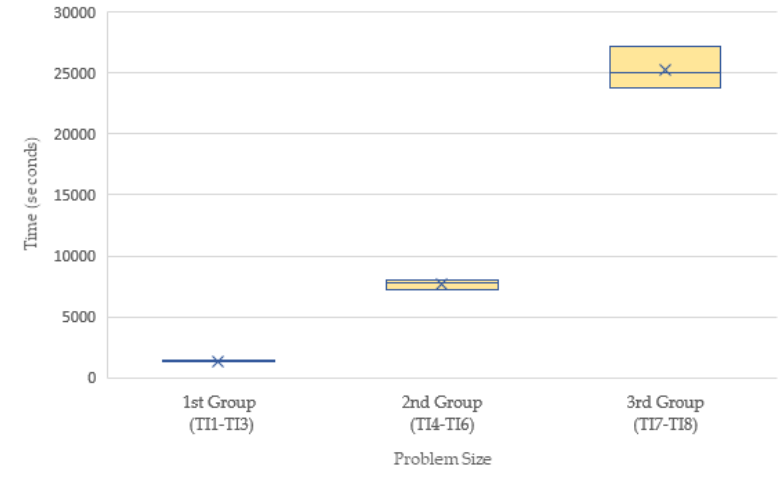
Figure 7. Box chart for the average TLBA computational